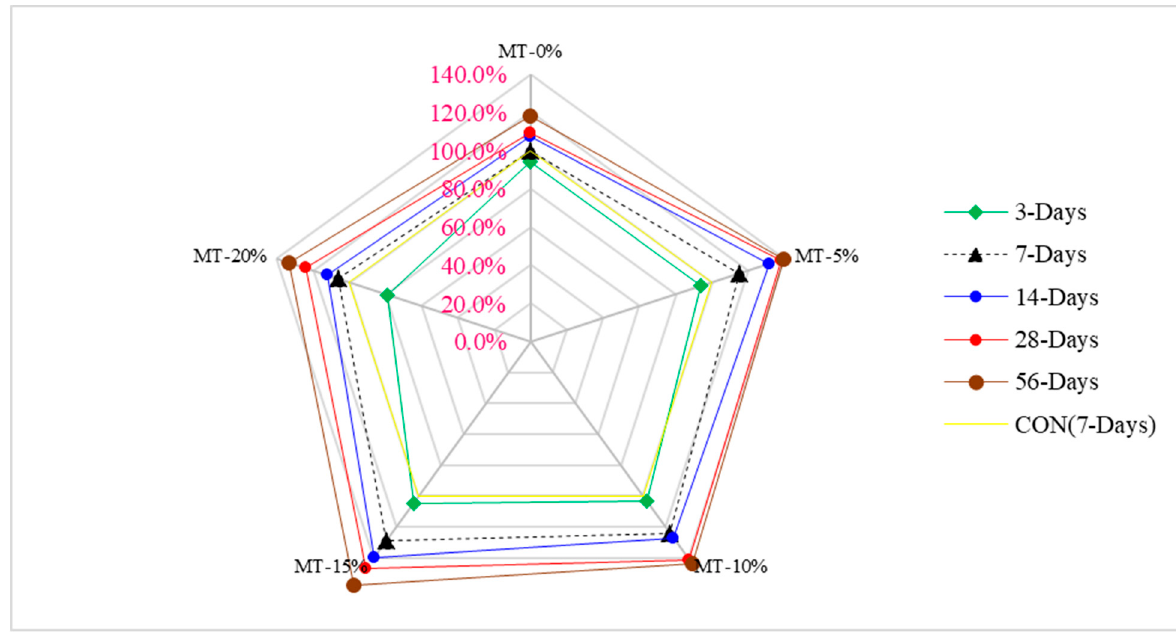
Figure 5. Compressive strength–age relationship: data source [55].